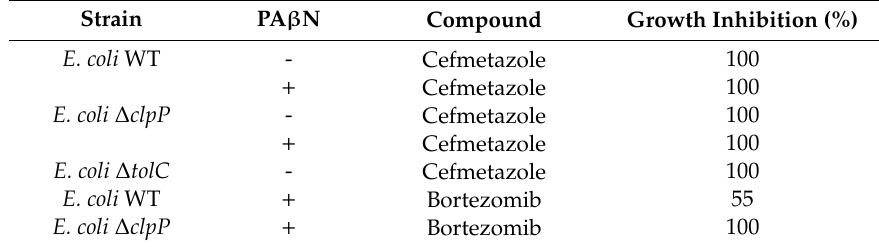
Table 3. Antibacterial evaluation of the ClpP inhibitors. All compounds were tested at 100 µ M concentration and growth inhibition was measured after 24 h of incubation at 37 ◦ C.